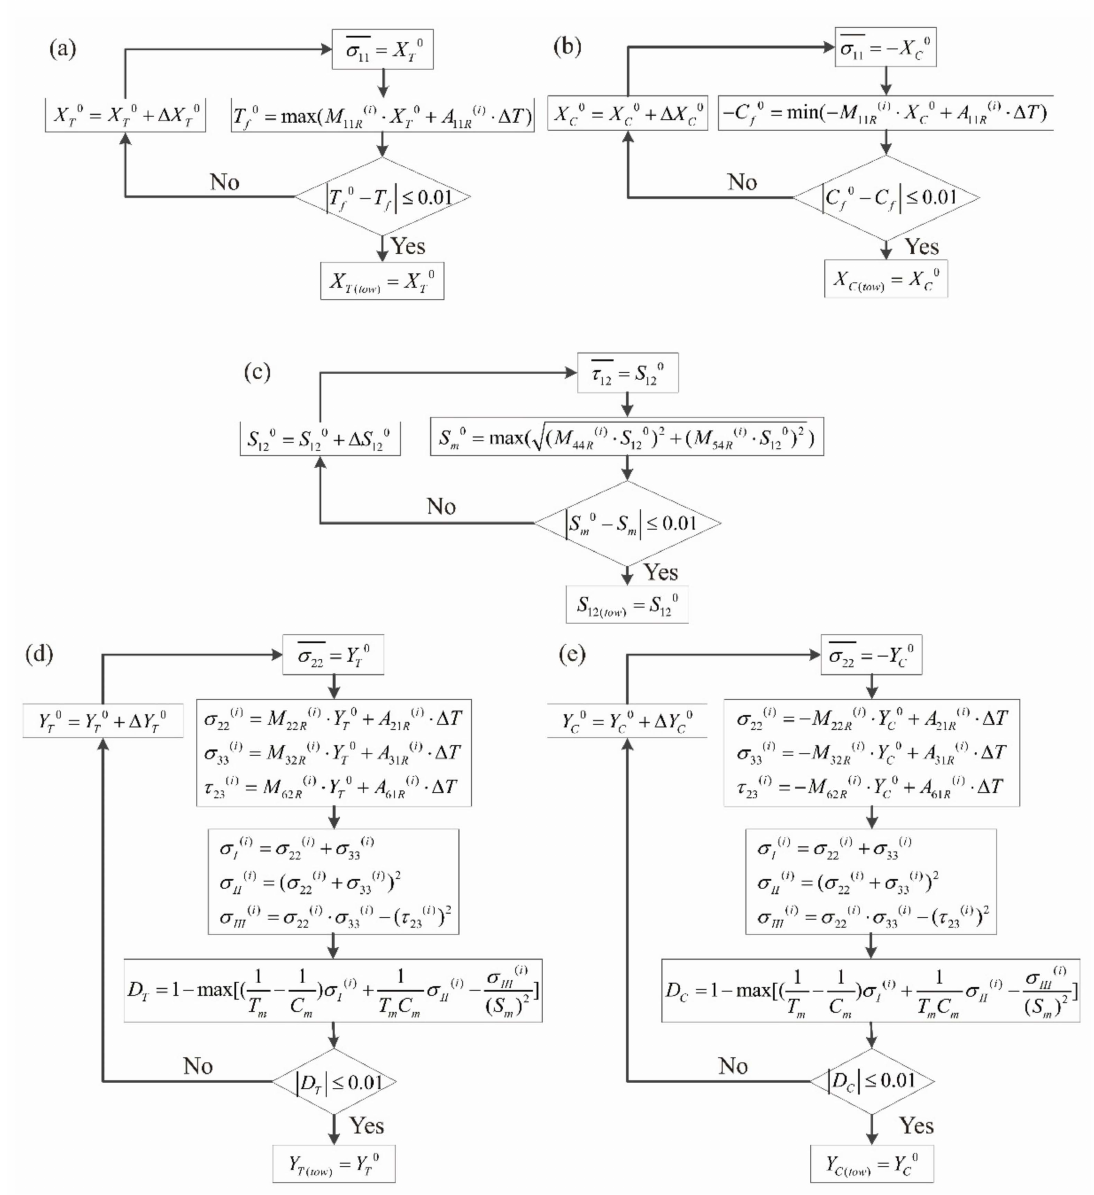
Figure 8. Procedures in determining the meso-scale strengths of fiber tows under the micro-scale strength invariant hypothesis: ( a ) procedure in determining X T(tow) ; ( b ) procedure in determining X C(tow) ; ( c ) procedure in determining S 12 (tow) ; ( d ) procedure in determining Y T(tow) ; ( e ) procedure in determining Y C(tow) . Table 6. Meso-scale strengths of fiber tows in T300/Cycom970 fabrics calculated under the